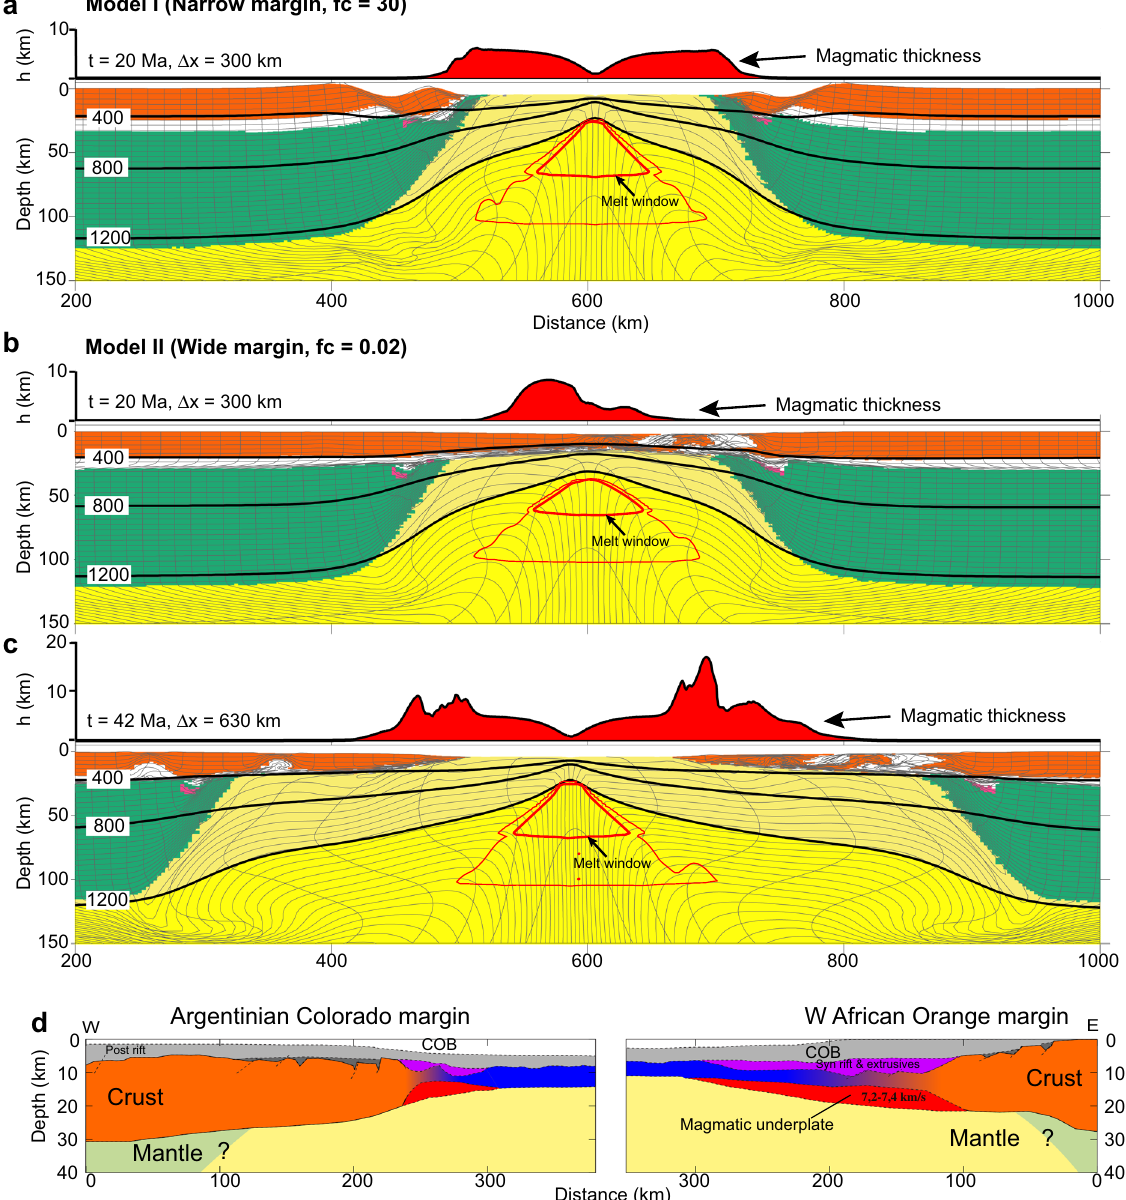
Fig. 2 Model evolution of contrasting rifting styles. a Model I with strong crust ( f c = 30). Bottom: composition overlain with contours of isotherms (black lines) in degree Celsius and incremental melt fraction (red lines). The thick red lines show melt windows with major decompression melting. Phase colours: upper crust, orange; lower crust, white; continental mantle lithosphere, green; asthenosphere, yellow; and oceanic lithosphere, pale yellow. Top: predicted magmatic thickness. t time since the onset of extension, Ma millions of years; Δ x , extension at full velocity 1.5 cm/year. b , c Model II with weak crust ( f c = 0.02). Note the earlier rupture of mantle lithosphere than crust and enhanced magmatic production in the distal margin. d Cross sections of wide Southern South Atlantic conjugate margins 68 . Colouring as in a . Also shown are magmatic underplate (red), extrusives (purple), oceanic crust (blue), syn- (dark grey) and post-rift (grey) sediments. COB continent-ocean Volcanic rifted margin models . Reference Model I (Fig. 2a) with mantle potential temperature ( T p ). We explore models with strong crust ( f c = 30) and normal mantle potential temperature, varying crustal strength to investigate the role of contrasting T p = 1300 °C, leads to narrow lithospheric breakup. The strong styles of rifted margin formation on magmatism. A Wet Quartz fl ow law is used for the crust 34 , which is scaled by a viscosity- coupling between frictional-plastic upper crust and upper mantle scaling factor, f c , to produce stronger or weaker crust. The melt lithosphere promotes narrow rupture of the whole lithosphere. The parameterization model follows ref. 24 (see “ Methods ” for details). transition from the COB to normal oceanic crust is within a dis- Melt parameters are calibrated by comparing predicted igneous tance of <30 km, with predicted melt thickness (i.e. igneous crustal crustal thickness with global oceanic crustal thickness 3 , with a thickness) gradually increasing from 0 to ~5.5 km, in the range of mantle potential temperature of 1300 °C resulting in on average normal global oceanic crust thicknesses 3,4 . Model II shows highly contrasting behaviour, with very weak crust ( f c = 0.02) allowing for 6-km thick oceanic crust (Supplementary Fig. 2).